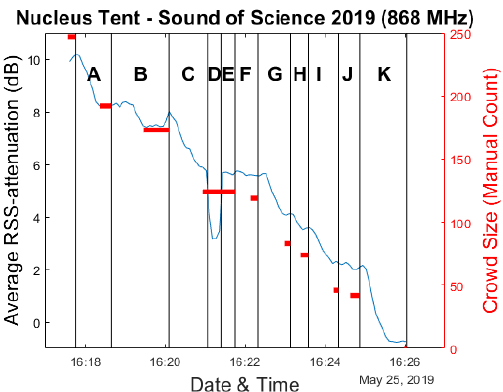
Figure 16. Evolution of the average RSS attenuation during the experiments in the Nucleus tent environment, overlaid with the ground truth data.